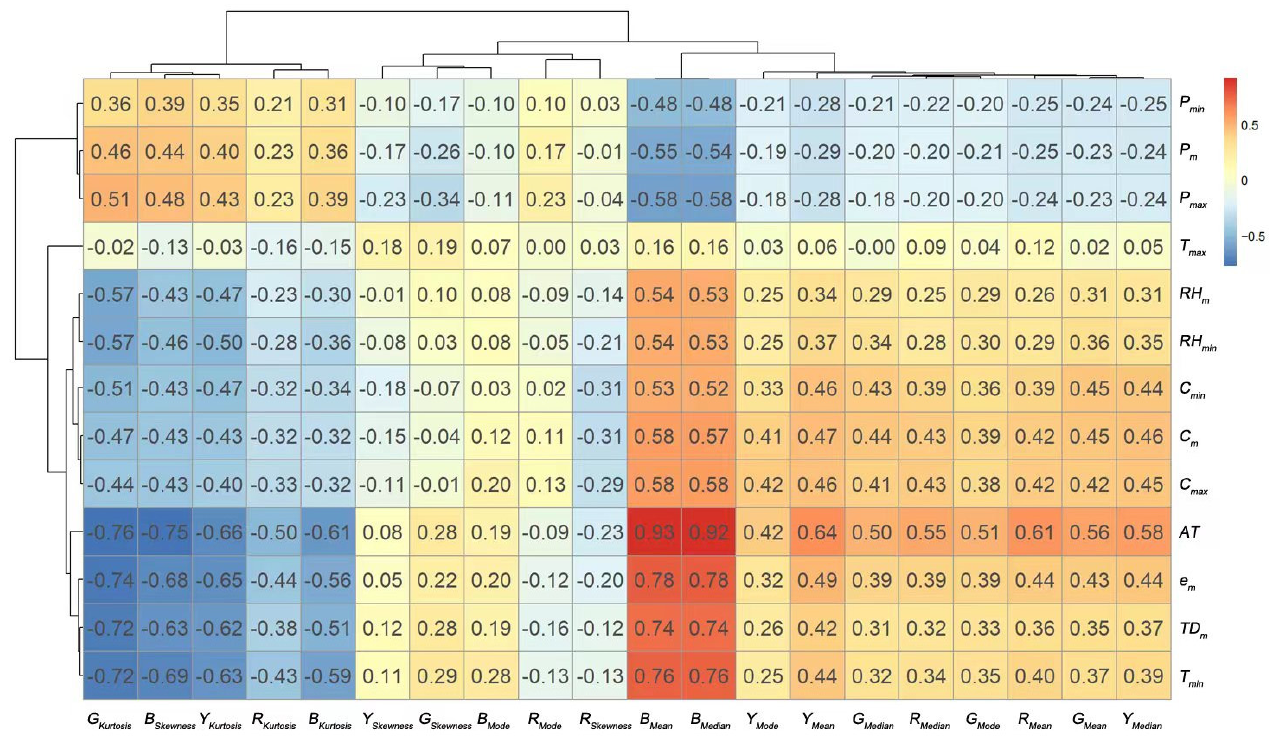
Figure 3. Spearman correlation coefficient of population canopy CGSD parameters of pepper and microclimate factors. A Spearman correlation analysis of SPSS software was used on 20 CGSD parameters ( R Mean , R Median , R Mode , R Skewness , R Kurtosis , G Mean , G Median , G Mode , G Skewness , G Kurtosis , B Mean , B Median , B Mode , B Skewness , B Kurtosis , Y Mean , Y Median , Y Mode , Y Skewness , and Y Kurtosis ), the microclimate factors, including daily meteorological factors ( T m , T max , T min , P m , P max , P min , RH m , RH min , TD m , e m , C m , C max , C min ), and accumulation factors ( AT ) ( n = 101). The correlation coefficient obtained by related analysis was drawn to CGSD parameters–daily meteorological factors heat map. The positive correlation coefficient is shown in red, and the negative correlation coefficient is shown in blue. Table 1. Canopy leaf color response regression models of pepper and their goodness of fit.